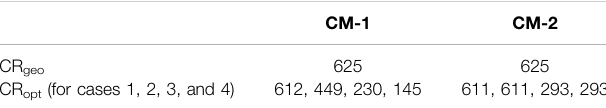
TABLE 2 | Concentration ratios of solar concentrator modules. Case 1: uniform ray and perfect re fl ectance, case 2: solar ray and perfect re fl ectance, case 3: uniform ray and aluminum re fl ectance, and case 4: solar ray and aluminum re fl ectance.